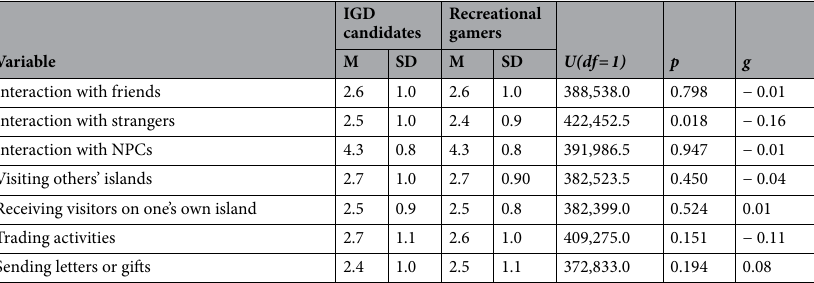
Table 3. Group differences in in-game activities.